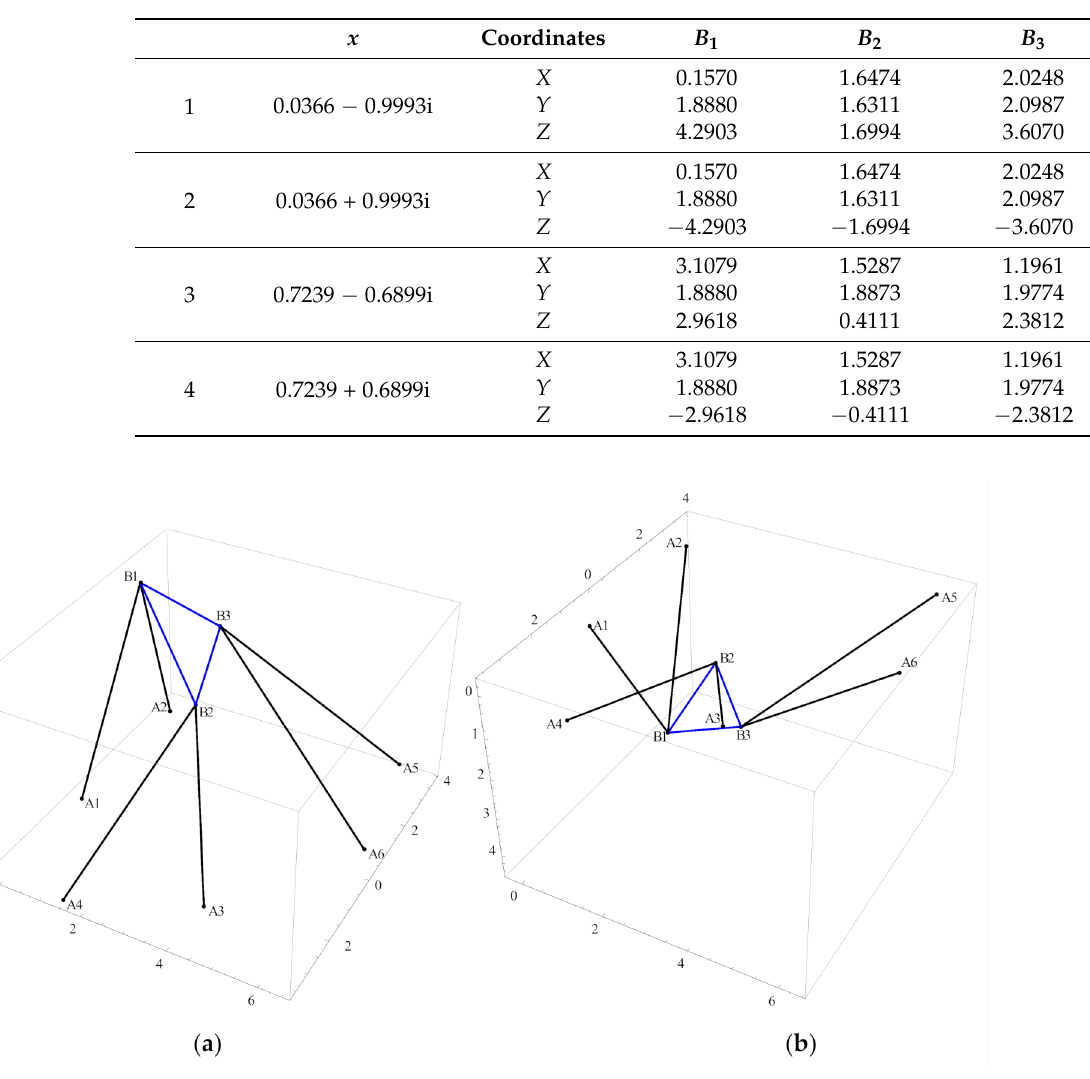
Table 4. Four sets of real solutions of point B i ( i = 1,2,3 ) .